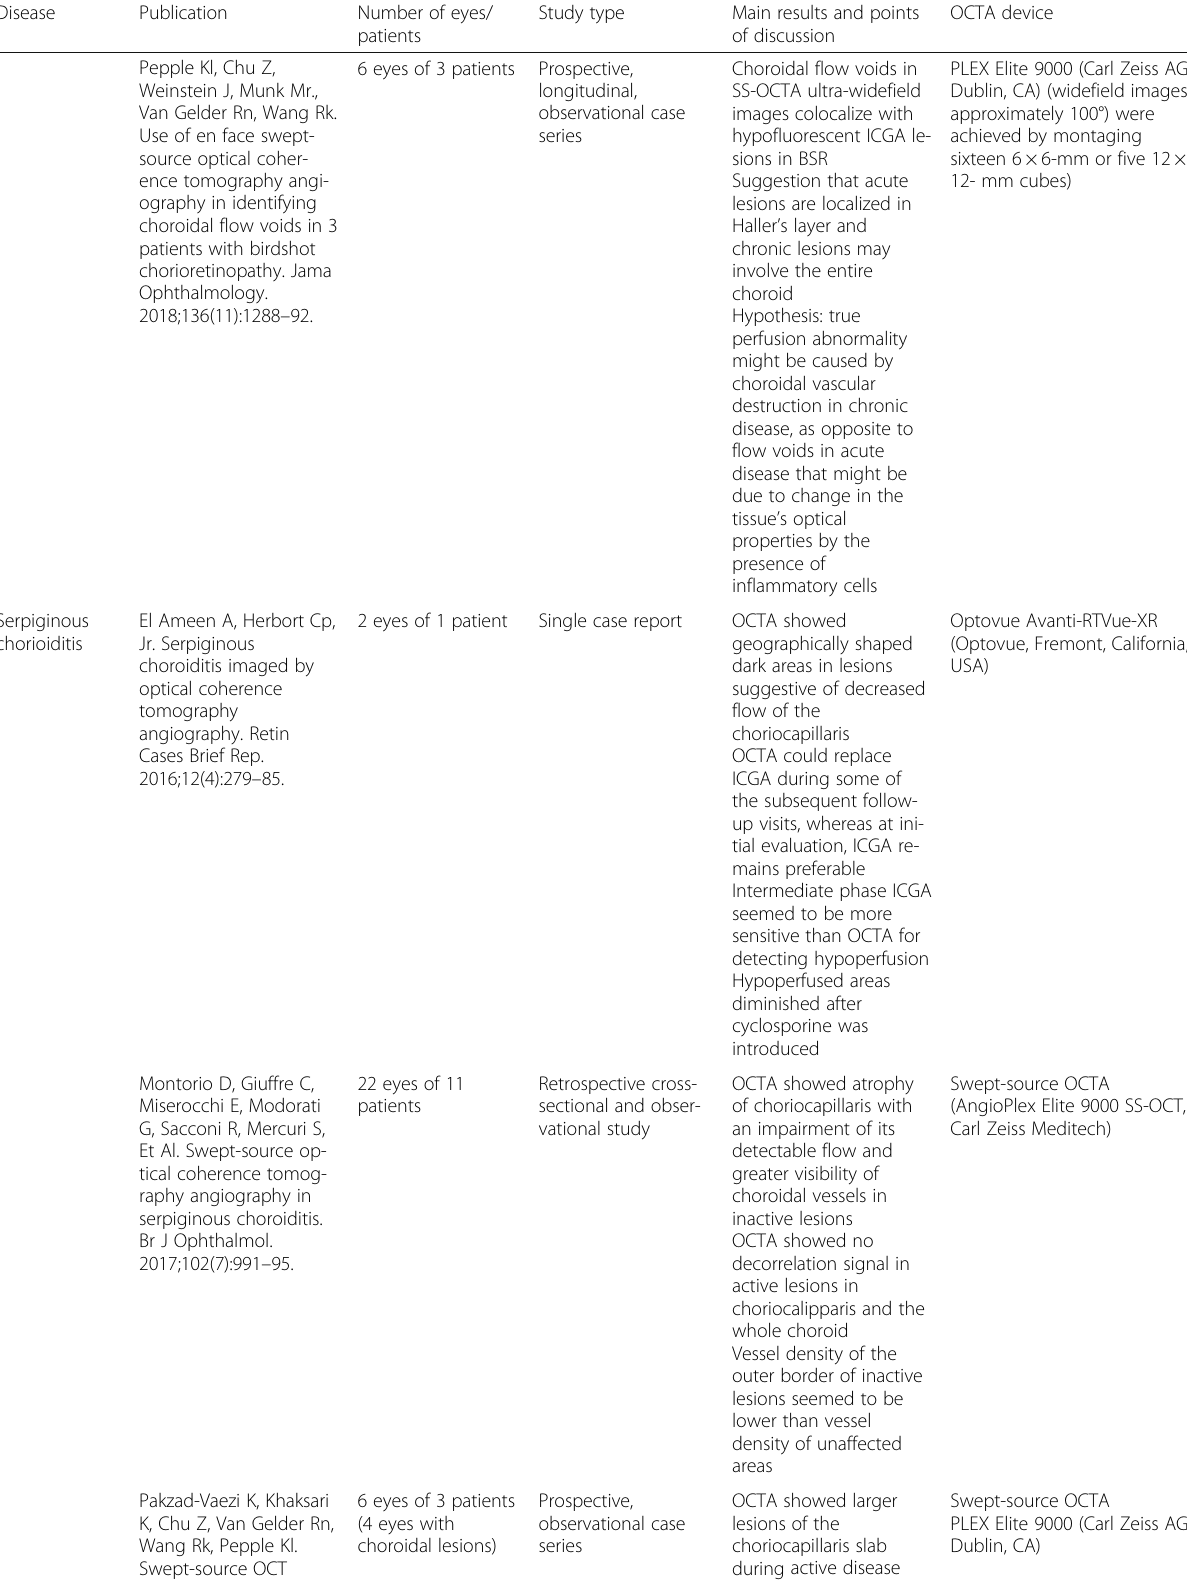
Table 1 Summary of publications on the implementation of OCTA in white dot syndromes (Continued)